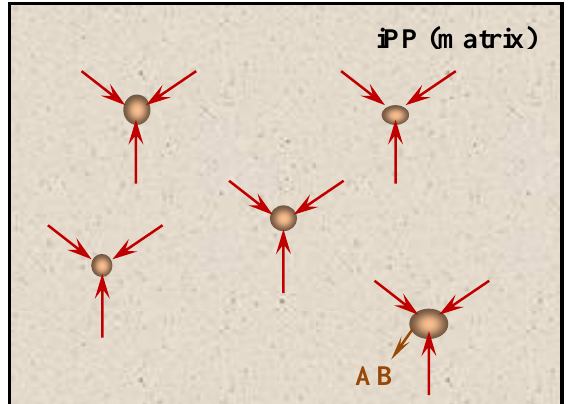
Figure 10. Diagrammatic drawing of a certain interfacial interaction between iPP and ABS when iPP is matrix.